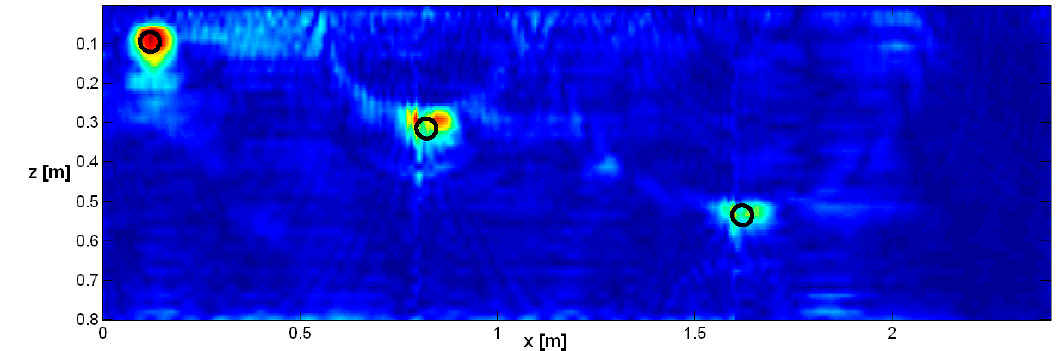
Figure 11. Reconstruction achieved with three adjacent investigation-observation domains, under a data shift of 35 cm. Remote Sens. 2017 , 10 , 980